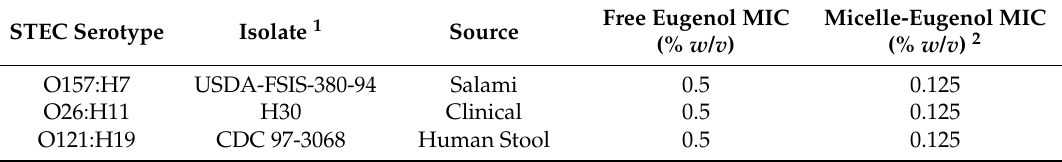
Table 1. Shiga toxin-producing Escherichia coli (STEC) isolates, sources, and minimum inhibitory concentrations (MICs) of free and micelle-loaded